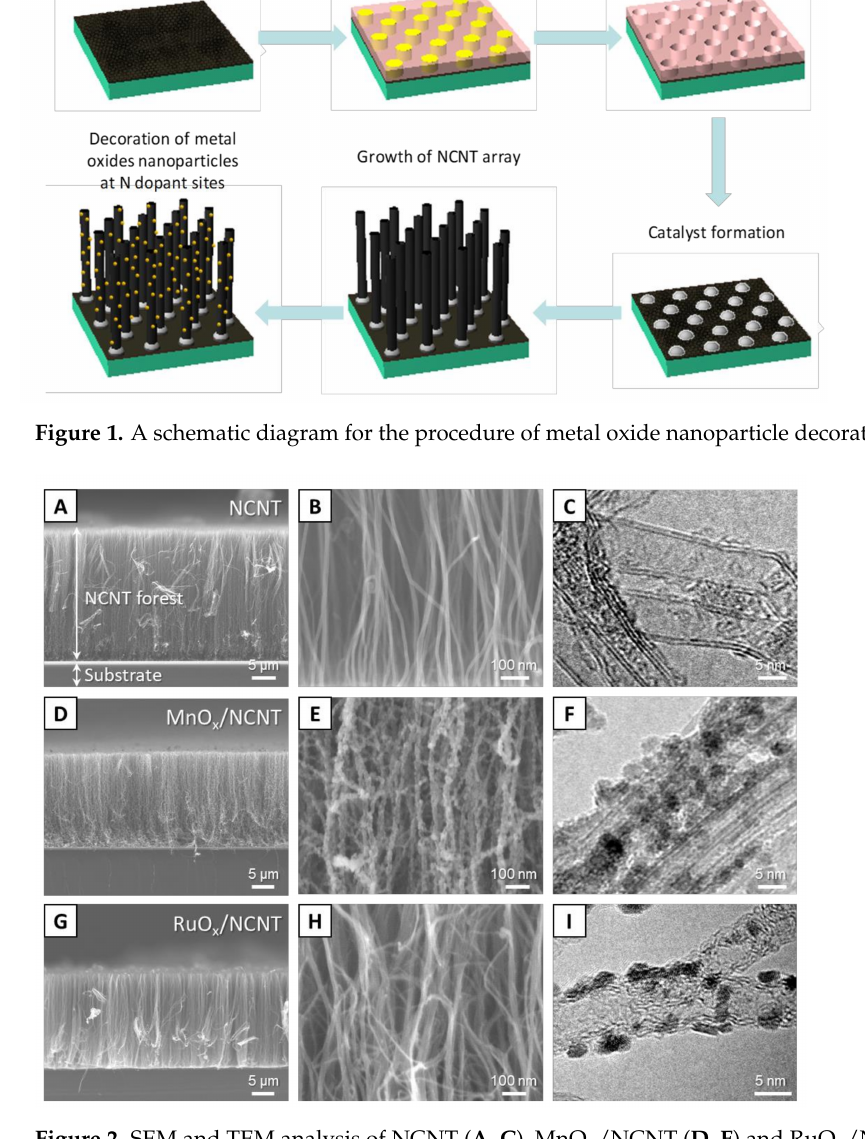
Figure 2. SEM and TEM analysis of NCNT ( A – C ), MnO x /NCNT ( D – F ) and RuO x /NCNT ( G – I